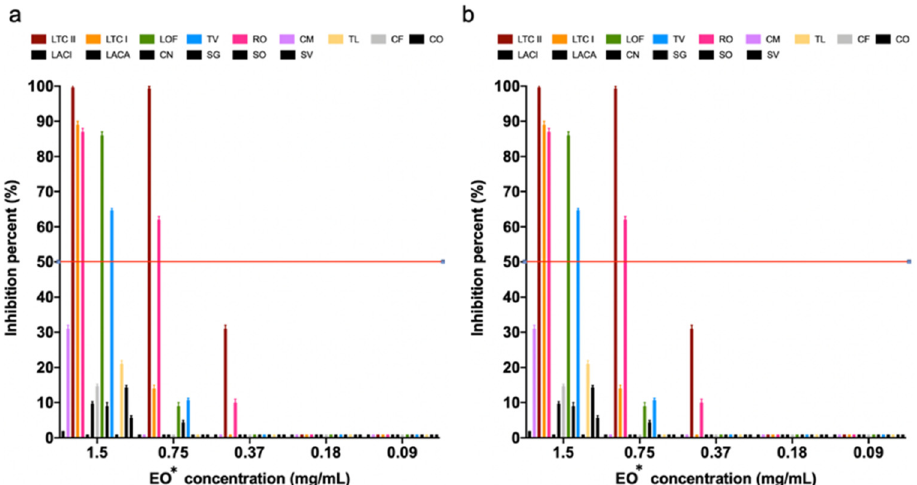
Figure 1. Inhibition effect of EOs on the growth of ( a ) S. aureus ATCC 29213 and ( b ) E. coli ATCC 25922 for MIC 50 and MBC determination. Inhibition percentages are presented as the mean ± SD of the absorbance measured at 595 nm with respect to the bacterial growth control. * LTC II ( L. origanoides thymol–carvacrol II chemotype), TV ( Thymus vulgaris ), CN ( Cymbopogon nardus ), LACI ( Lippia alba citral ), SO ( Salvia officinalis ), LTC I ( L. origanoides thymol–carvacrol I chemotype), CF ( C. flexuosus ), LACA ( L. alba carvona ), LOF ( L. origanoides felandreno ), CM ( C. martini ), RO ( Rosmarinus officinales ), TL ( Tagetes lucida ), SV ( Satureja viminea ), CO ( Cananga odorata ), SG ( Swinglea glutinosa